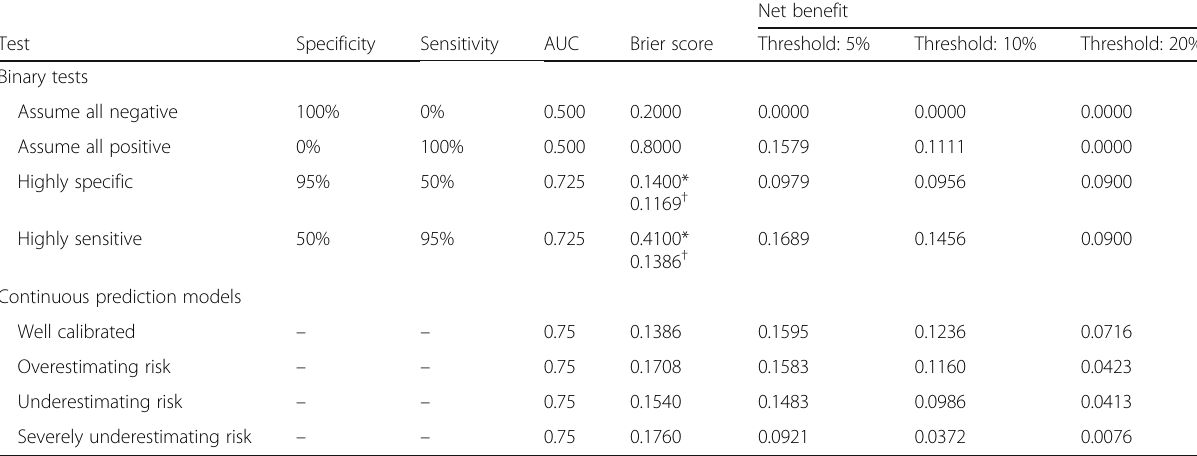
Table 1 Performance characteristics of binary tests and continuous prediction models with various degrees of miscalibration. All values given were calculated directly from the formulae in the text and independently verified using a simulation